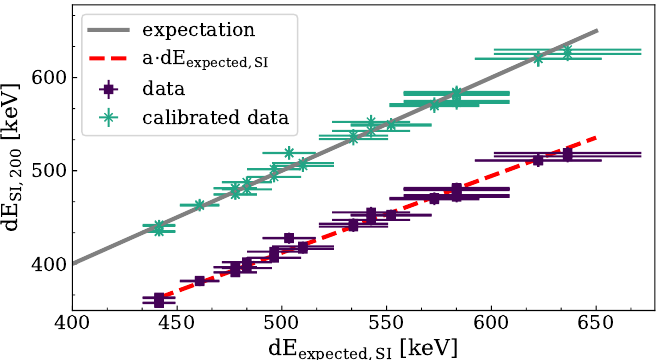
Figure 9. Measured mean deposited energy in silicon dE SI,200 versus the expected deposited energy dE expected,SI . Results are plotted before (purple squares) and after calibration (green